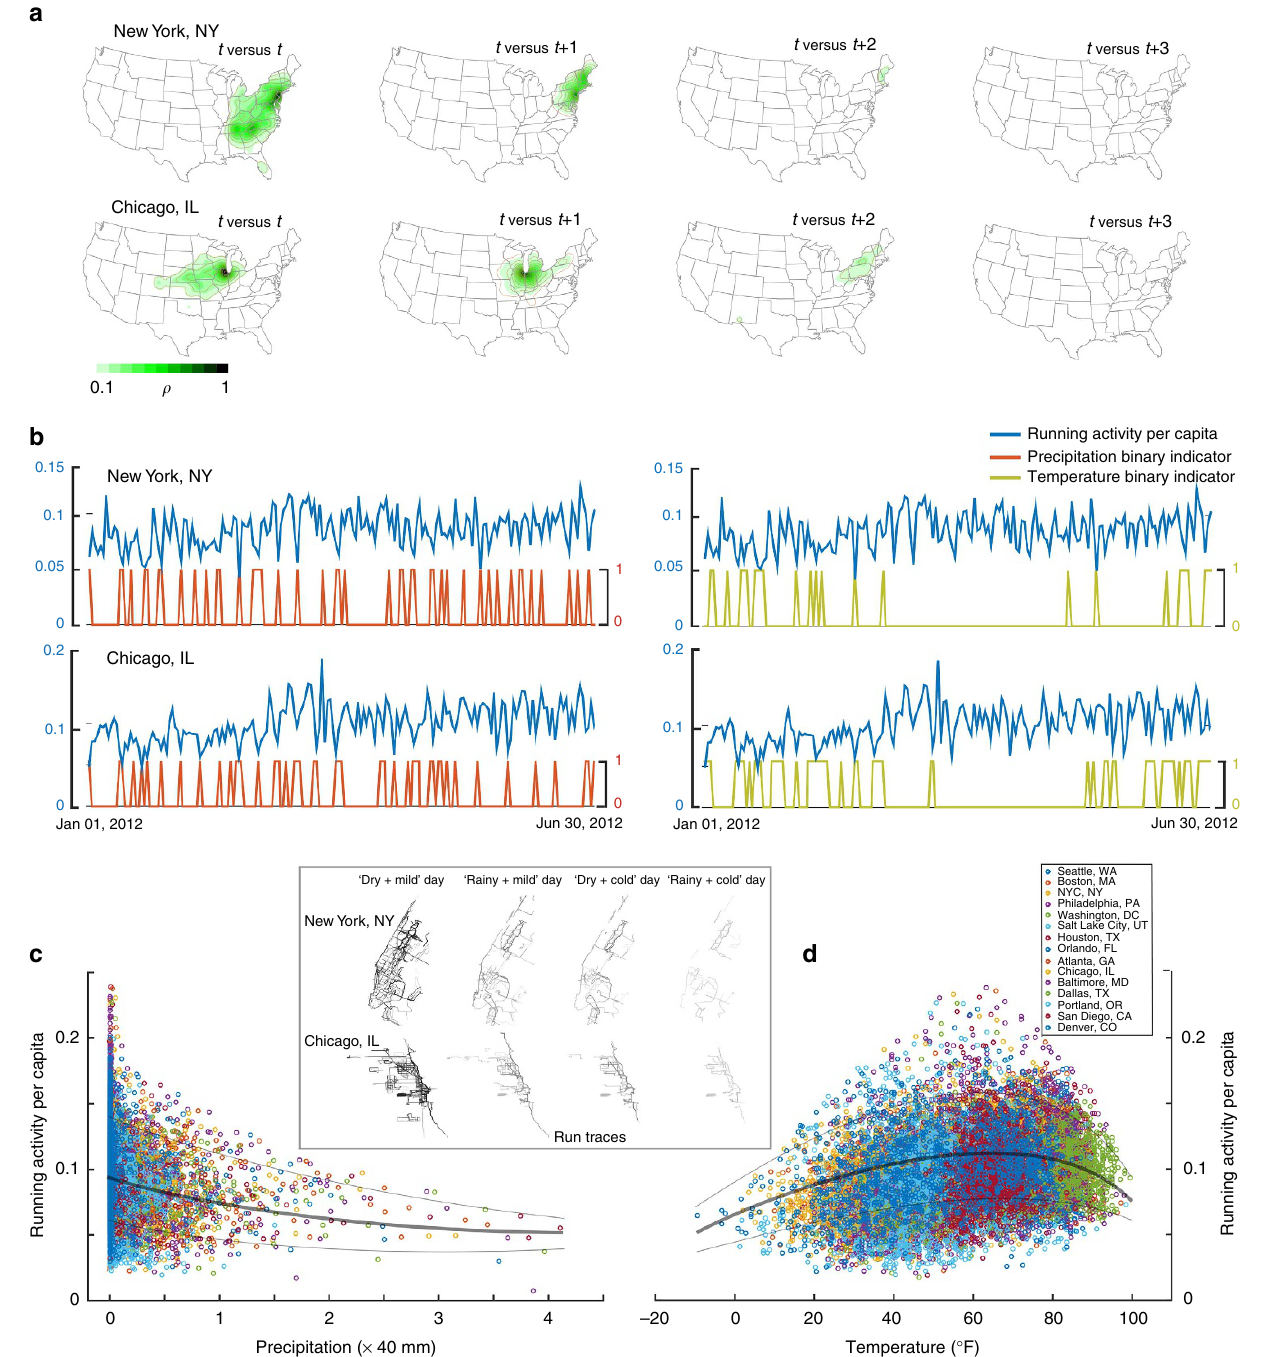
Figure 4 | The strength and exogeneity of weather patterns as instrumental variables for running behaviours. Panel ( a ) displays daily correlations between precipitation in New York and Chicago at time t and precipitation in the rest of the United States at time t , t þ 1, t þ 2 and t þ 3. White colouring indicates no correlation, while progressively darker green colouring indicates proportionally stronger correlations. Panel ( b ) displays daily correlations between running activity per capita and binary indicators of rainfall above the annual average and temperature o 35 (cid:2) or 4 85 (cid:2) in New York and Chicago, respectively. At nearly each spike in rainfall or extreme temperature, running declines markedly, visually demonstrating the strength of the instruments at the daily level. Panel ( c ) displays running activity per capita on the y axis and precipitation in millimetres on the x axis, while ( d ) displays running activity per capita on the y axis and temperature in degrees Fahrenheit on the x axis for the top 15 running cities in the United States during the 5-year period. These two panels show strong correlations between the weather and running behaviour and demonstrate that the correspondence of precipitation and temperature to running display different functional forms, necessitating differential approaches to constructing the precipitation and temperature instruments. The inset panel displays the aggregated run traces of the same number of randomly chosen global positioning system-enabled runners on a dry and mild day, a rainy and mild day, a dry and cold day and a rainy and cold day in New York and Chicago, with fewer traces indicating fewer runs by those